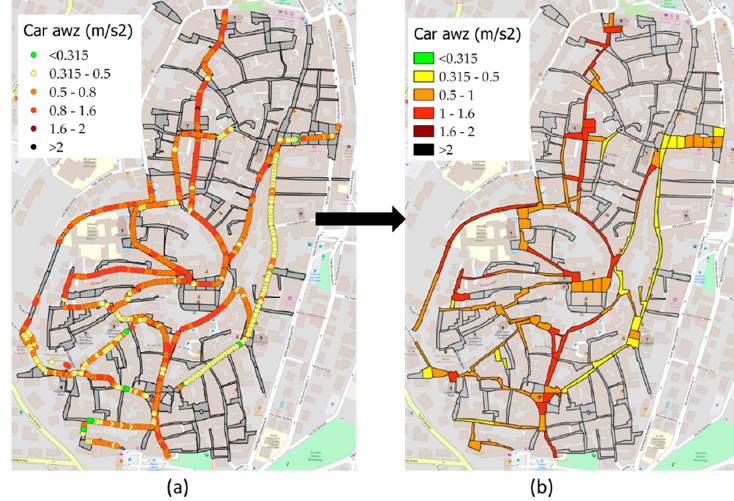
Figure 16. a wz car results in terms of: ( a ) points and ( b ) areas.